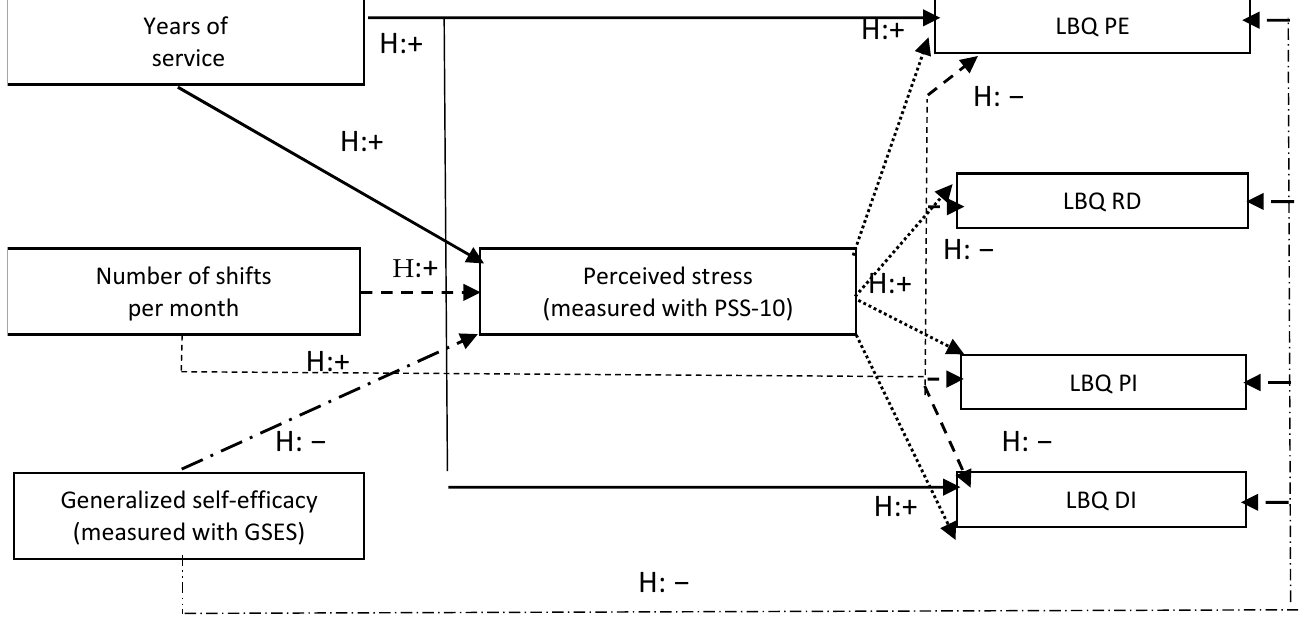
Figure 1. A proposed model of mutual links between experiences relating to ECDs’ work in the study on occupational burnout among Polish ECDs. GSES—General Self-Efficacy Scale, PSS-10—Perceived Stress Scale, LBQ—Link Burnout Questionnaire: PE—psychophysical exhaustion, RD—relationship deterioration, PI—sense of professional inefficacy, DI— disillusion.